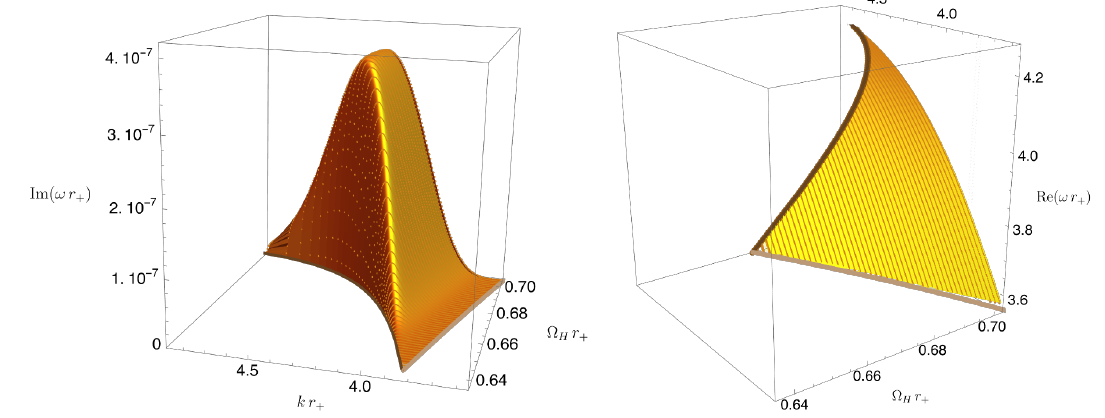
Figure 7 . Frequency for m = 3 unstable superradiant modes, as a function of parameters of √ Myers-Perry black strings. The instability is present (i.e. Im ω > 0 ) for e Ω H | c 0 ≤ e Ω H ≤ 1 / 2 , with e , and e k ? ( e Ω H ) ≤ e k ≤ e k ( e Ω H ) . The zero mode curve e k ( e Ω H ) (and Im ω = 0 ) was e Ω H | c 0 = 5 √ e (0) (0) 61 computed independently (see c 0 A 0 ) in figure 6 and we show it as a continuous brown line in the Im ω = 0 plane. On the other hand, the light-brown curve represents the confining cutoff line e k ? ( e Ω H ) e as defined parametrically in (4.12) for m = 3 (i.e. the cutoff curve c 0 B 0 in figure 6). It meets the zero mode curve at e Ω H | c 0 .